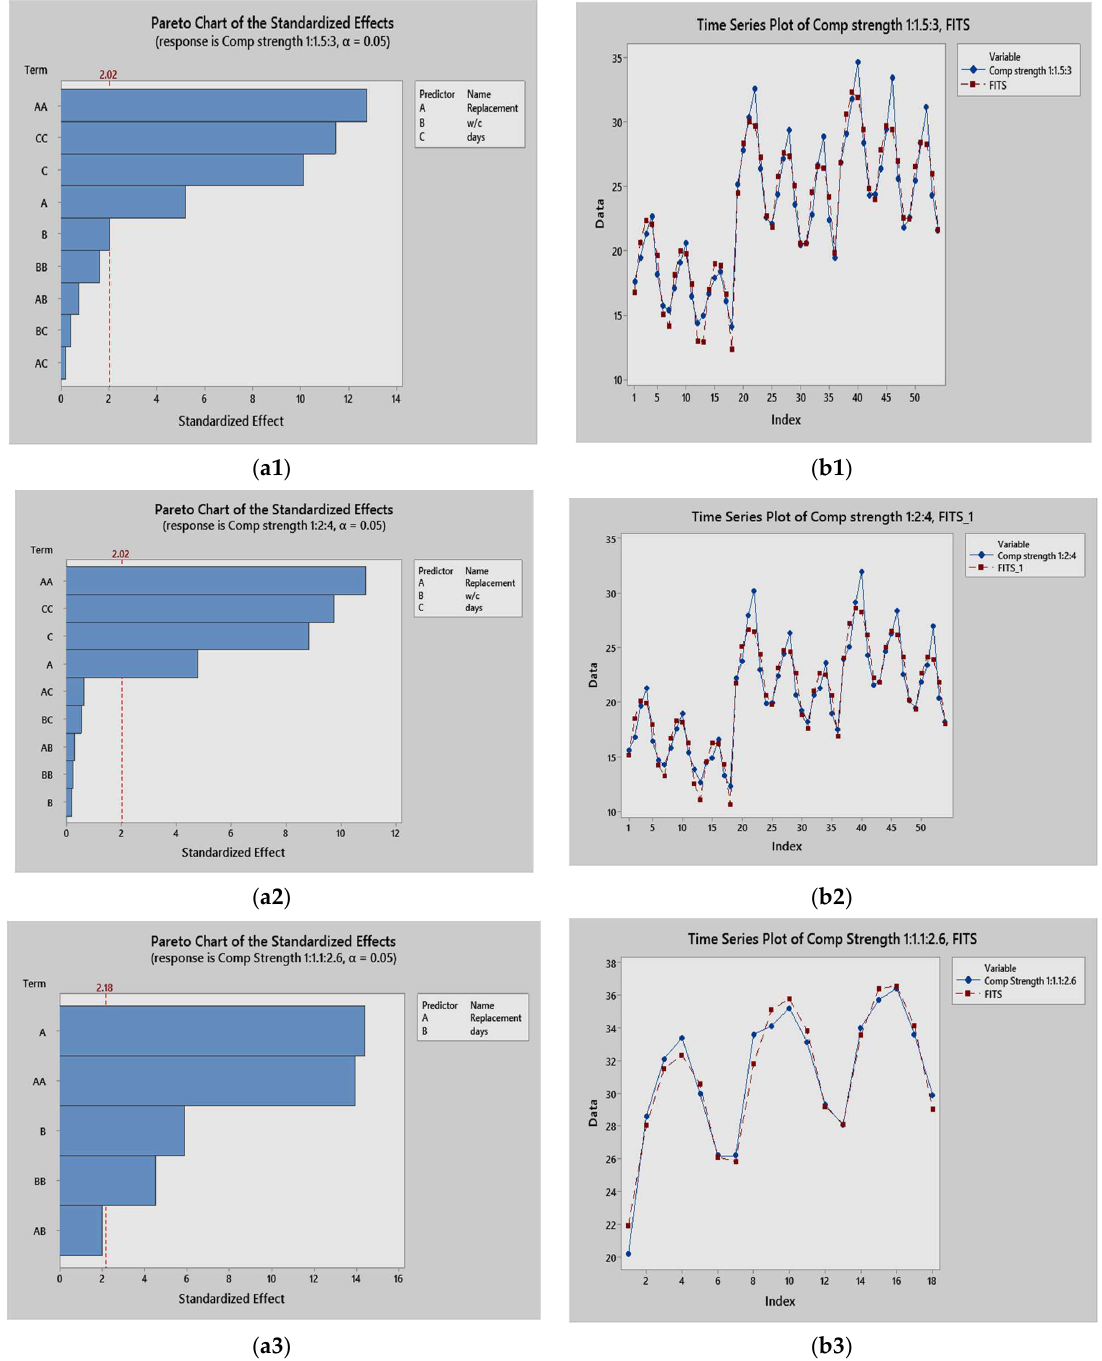
Figure 13. ( a1 – a3 ): Pareto charts of the standardized effects of the independent variables on the dependent variable; ( b1 – b3 ) experimental data versus predicted. ( a1 ) 1:1½:3; ( b1 ) 1:1½:3; ( a2 ) 1:2:4; b1 – b3 ) experimental data versus predicted. ( a1 ) 1:1 1 / 2 :3; ( b1 ) 1:1 1 / 2 :3; ( a2 ) 1:2:4; ( b2 ) 1:2:4; ( a3 ) 1:1.1:2.6; ( b3 ) 1:1.1:2.6. dependent variable; ( ( b2 ) 1:2:4; ( a3 ) 1:1.1:2.6; ( b3 )